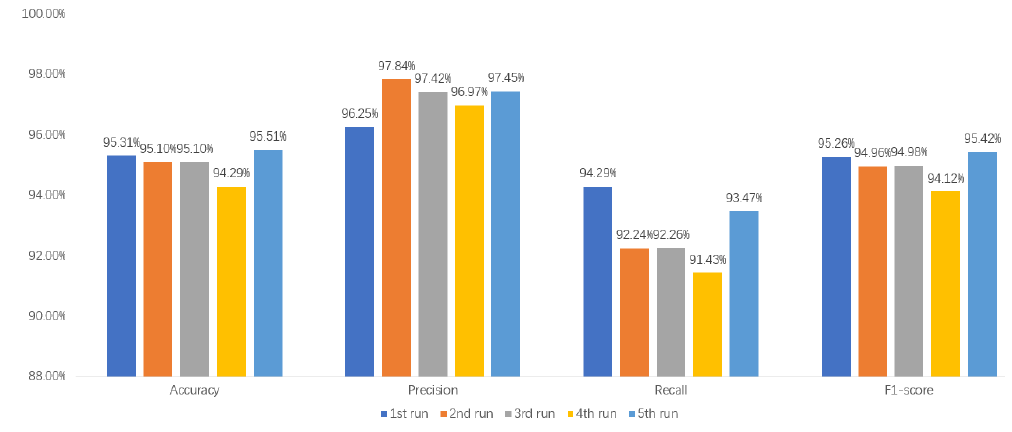
Fig.13 Confusion matrix of five times model